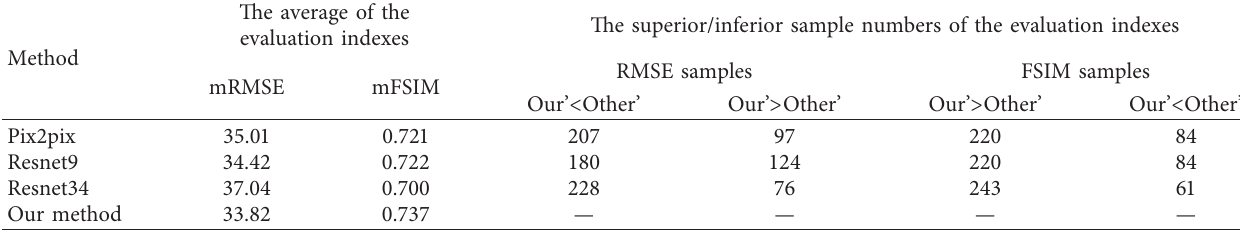
Table 2: The average and the superior/inferior sample numbers of the evaluation